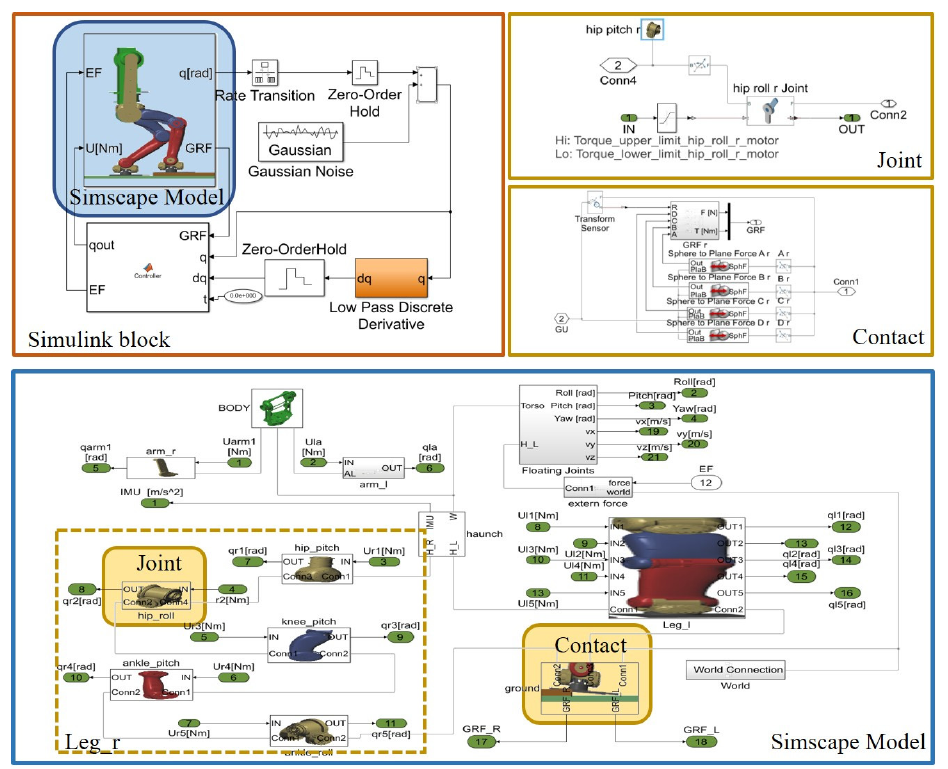
Figure 6. Simscape block of the simulated model.